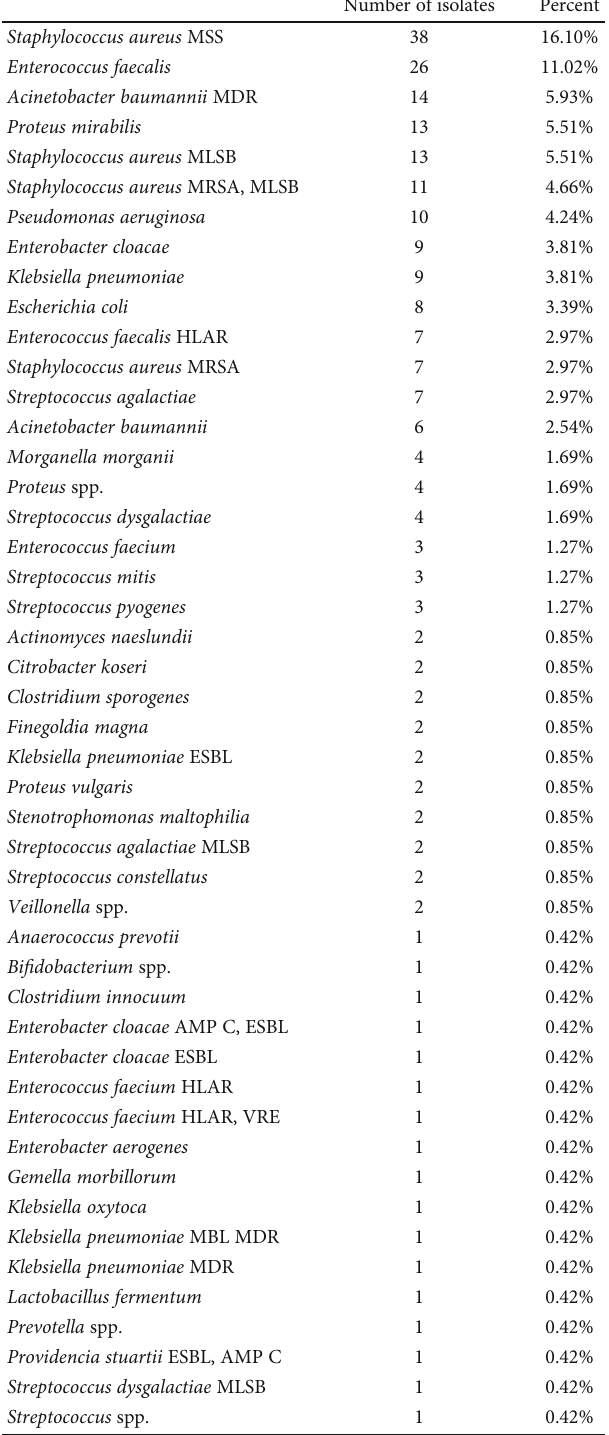
Table 3: Number of particular bacterial isolates in all patients with ischemic diabetic foot